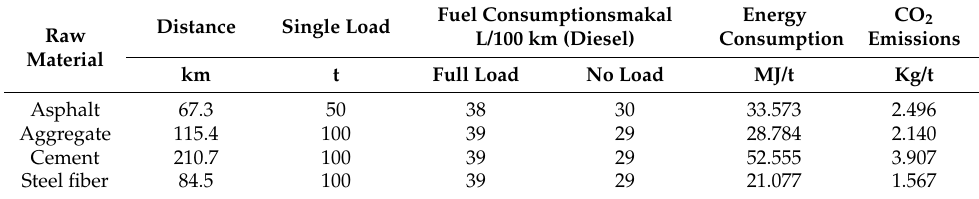
Table 4. Transportation list of raw